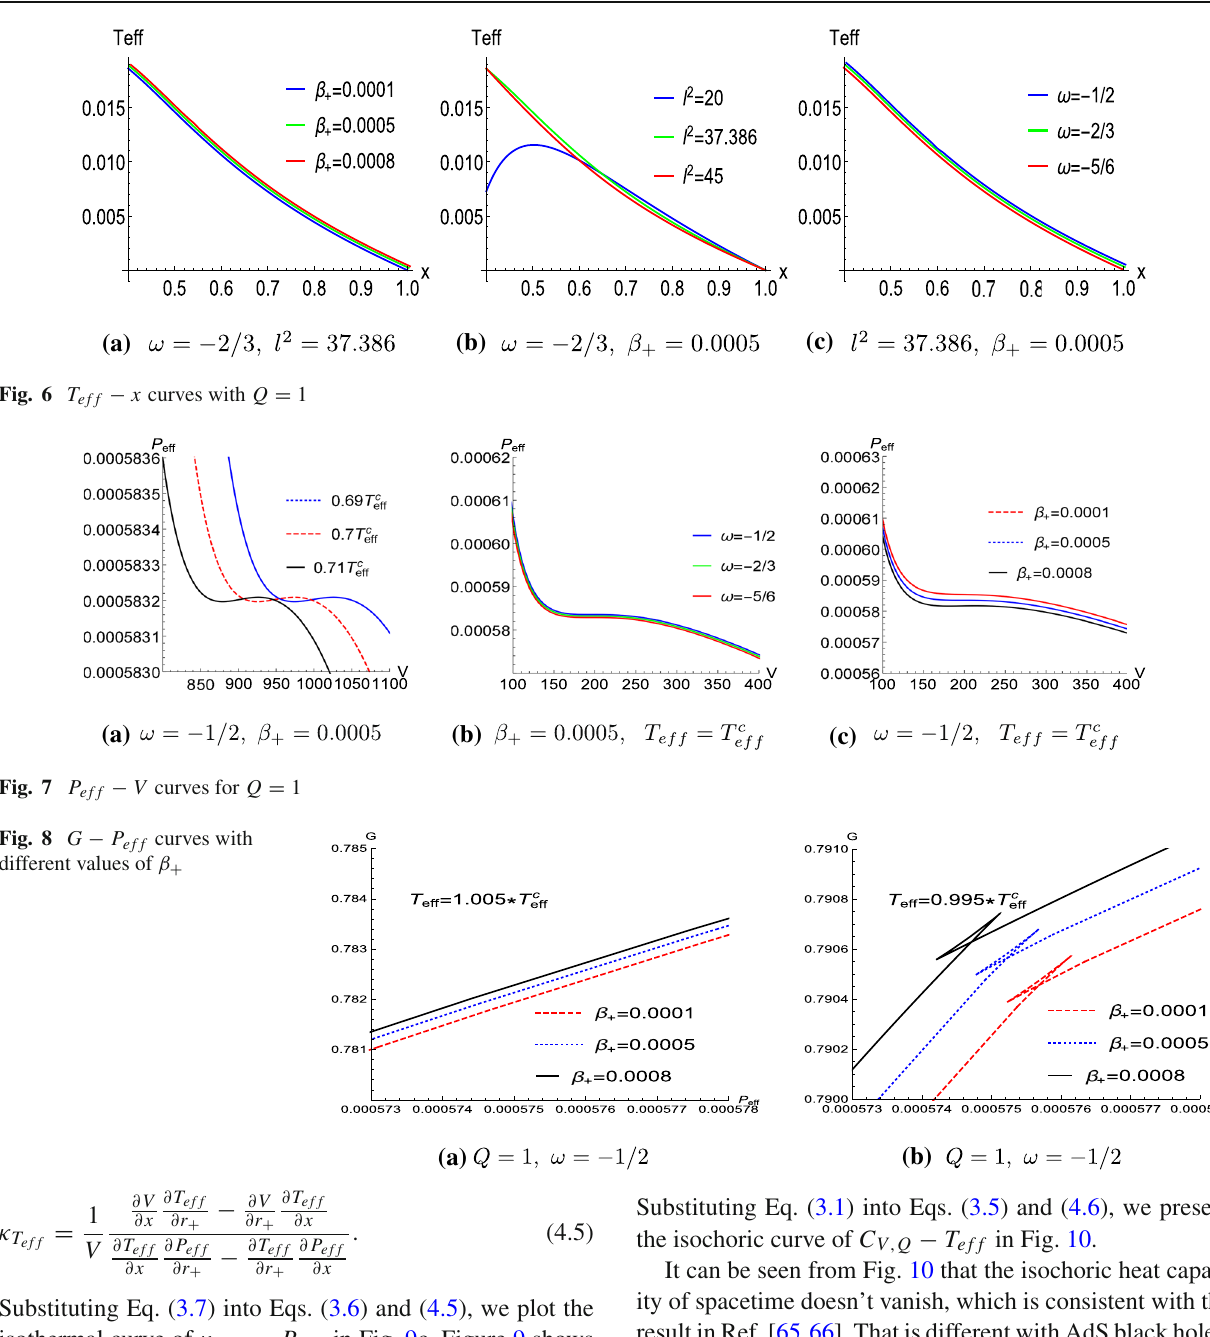
Fig. 7 P ef f − V curves for Q = 1 Fig. 8 G − P ef f curves with different values of β